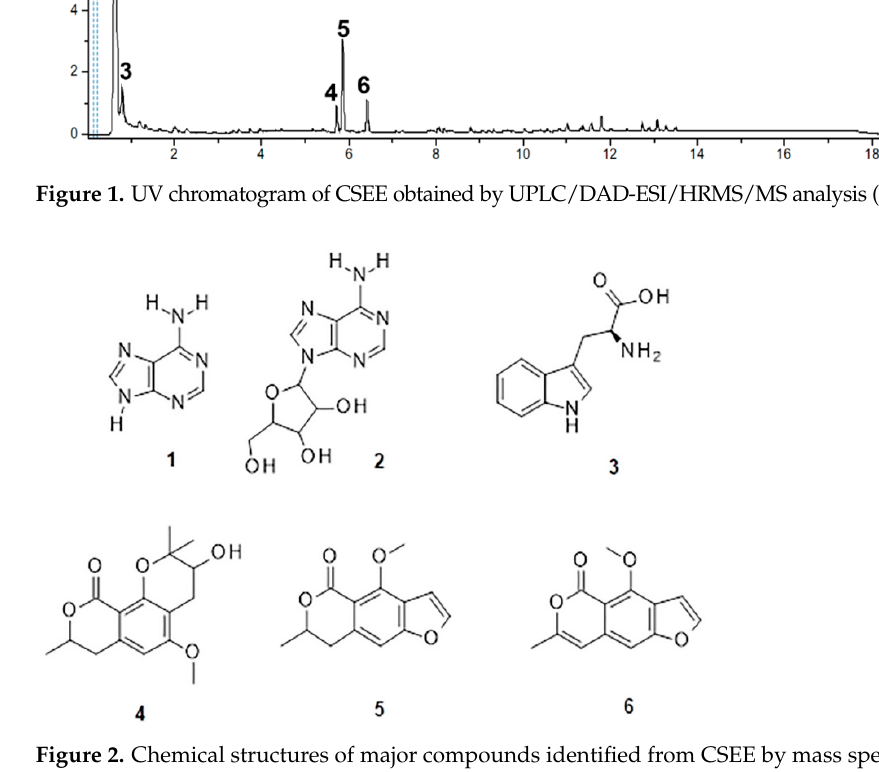
Table 2 . Compounds identified at CSEE thought UPLC/DAD-ESI/HRMS/MS analysis.